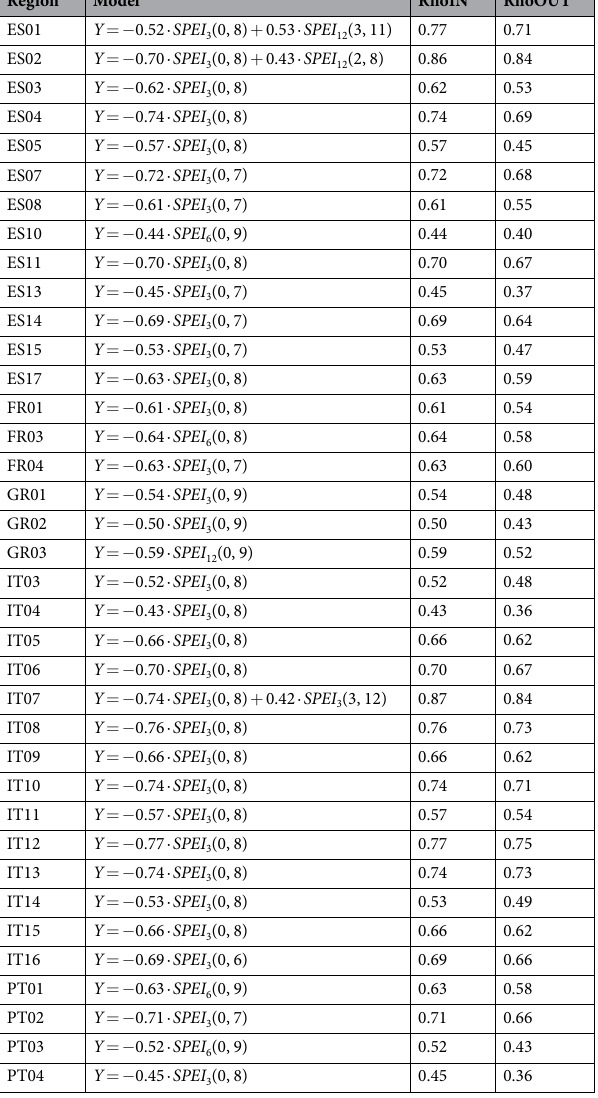
Table 1. Empirical SPEI-fire models (Eq. 1) for each eco-region (labelled according to Fig. S1) and the correlation for the reconstruction model (RhoIN: in-sample) and for the leave-one-out cross validation model (RhoOUT: